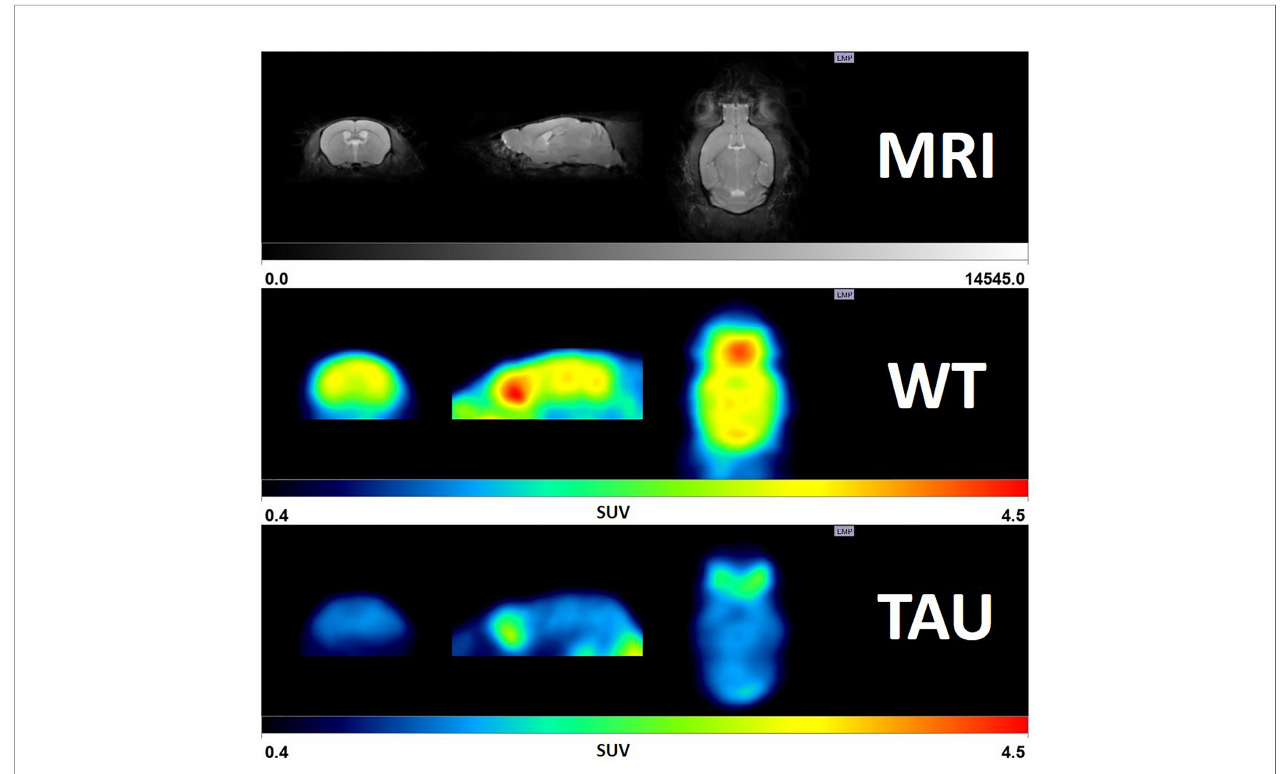
FIGURE 2 | Glucose uptake in a transgenic model of tauophathy (TAUwlv transgenic mice) compared to control (wild type) animals at the age of 19 months, as detected by 18F-FDG PET neuroimaging. The upper row shows a MRI mouse brain template (coronal, sagittal and transversal views); the middle and the bottom rows show the PET image (normalized to SUV -standard uptake value-) corresponding to a representative wild-type and TAUvlw mouse,